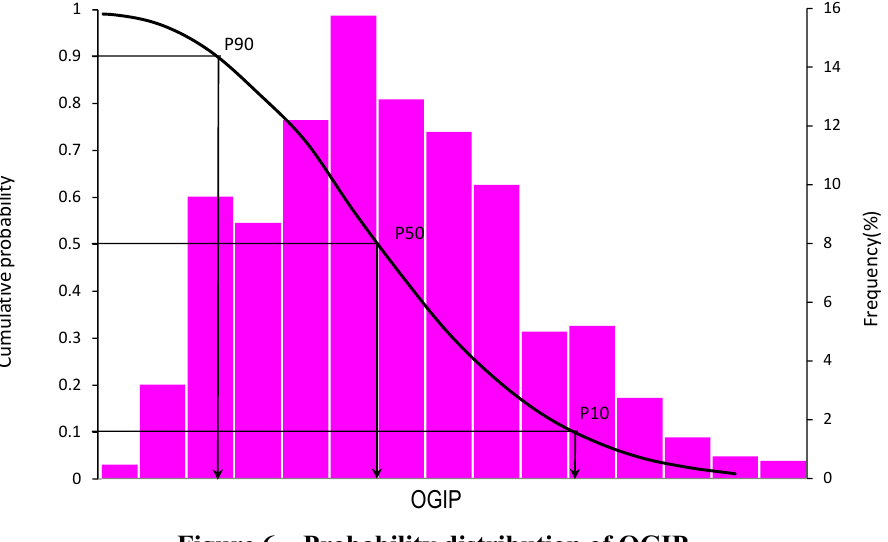
Figure 6—Probability distribution of